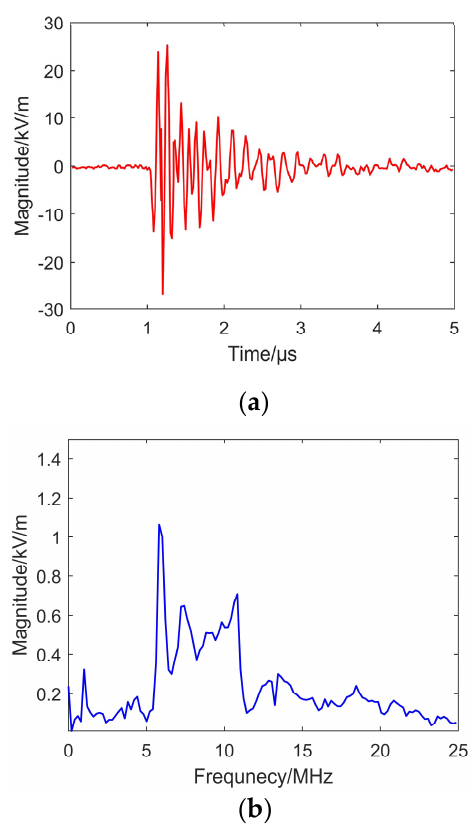
Figure 5. Typical measured spatial electric field waveform. ( a ) Time domain waveform; ( b ) spec- trogram.